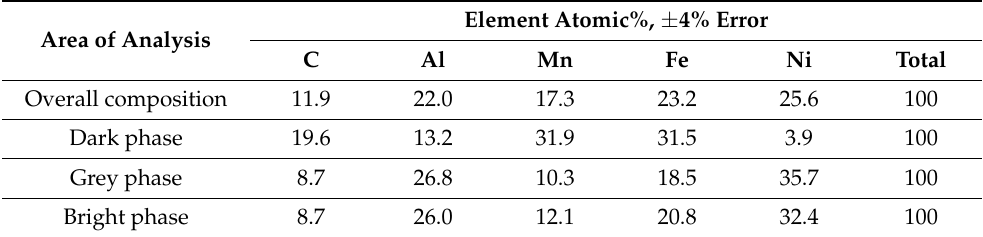
Table 1. Chemical composition of materials and present phases.